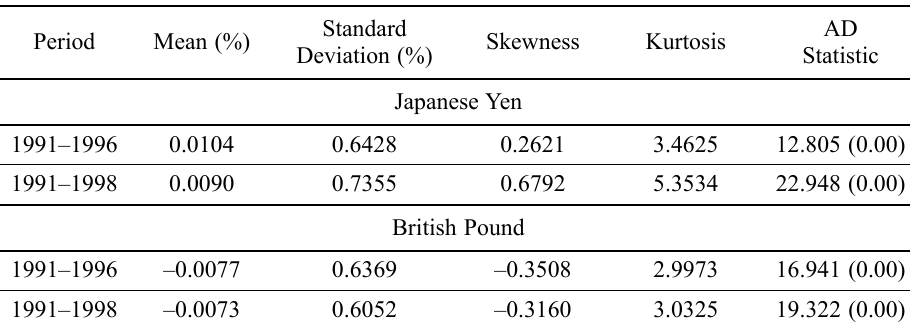
Table 1. Summary statistics for foreign exchange return distributions